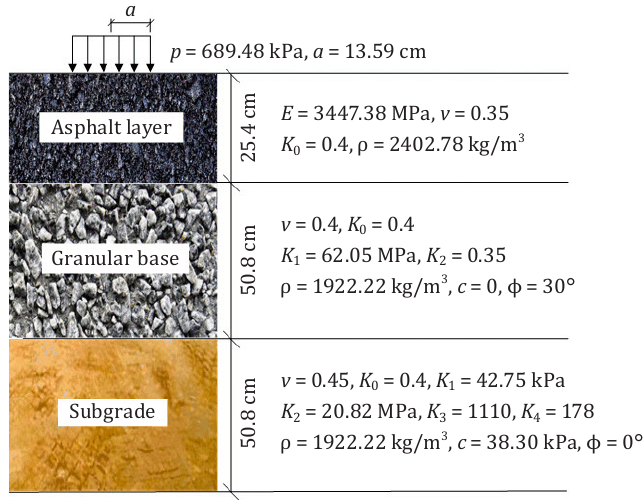
Figure 7. The schematic diagram of the pavement